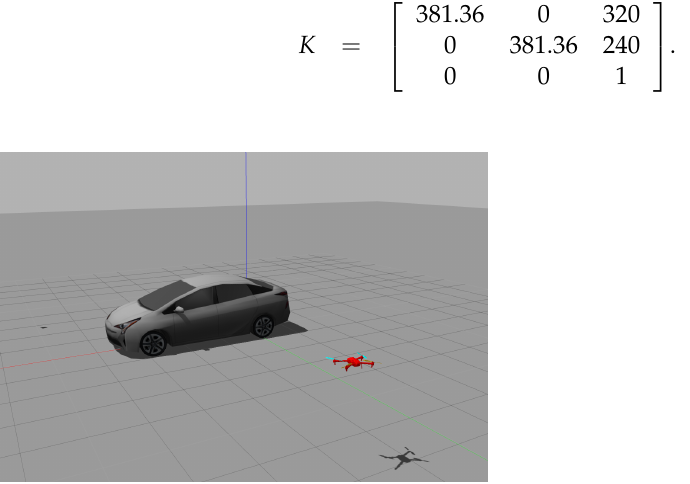
Figure 5. Setup of the car and UAV.